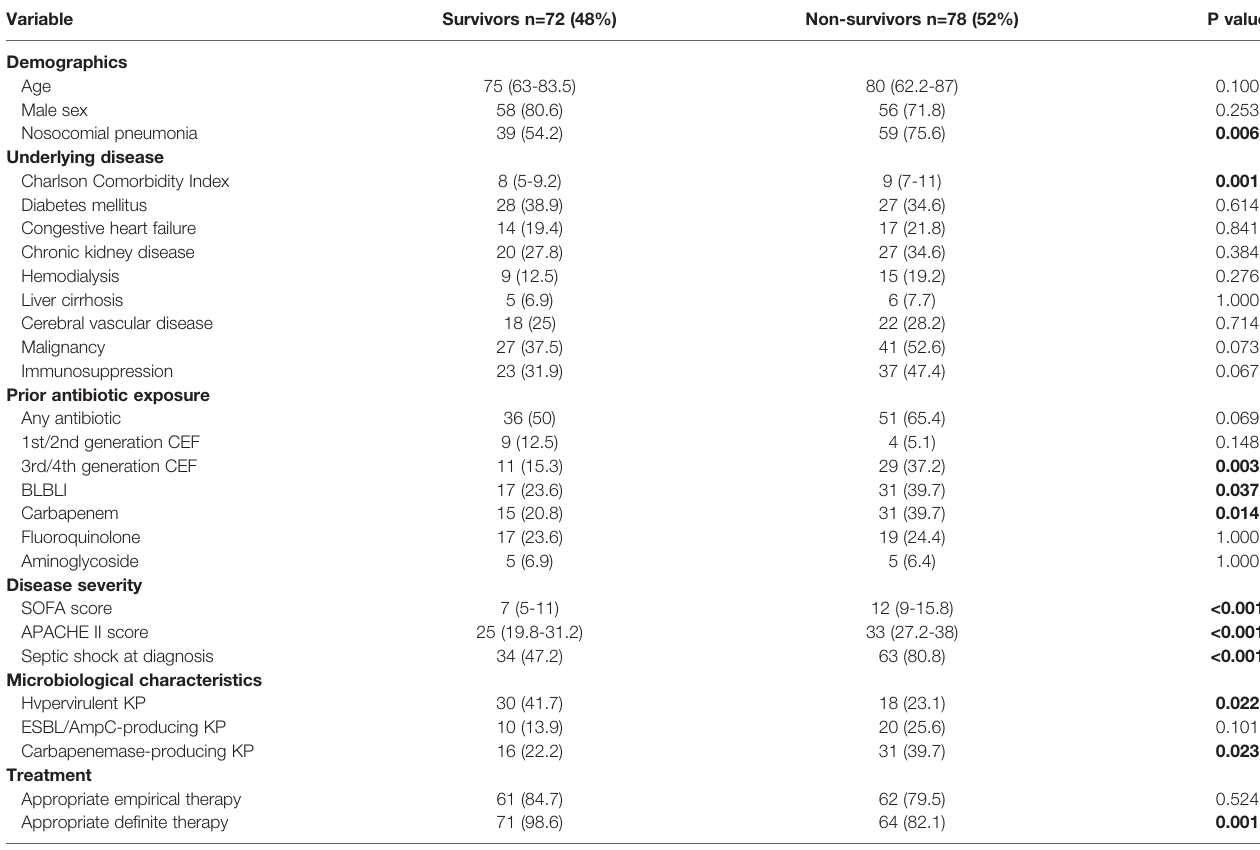
TABLE 4 | Characteristics of 28-day survivors and non-survivors.